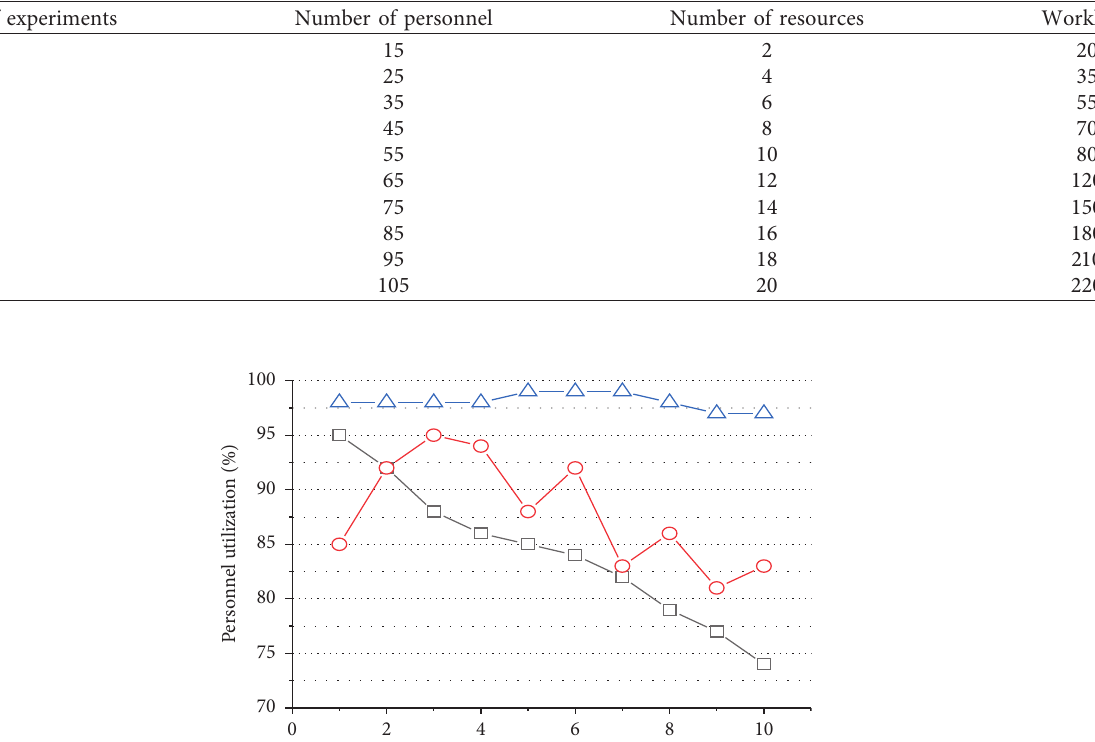
Figure 6: Relationship among personnel, resources, and tasks in enterprises. Table 1: Comparison of resource utilization of different algorithms.